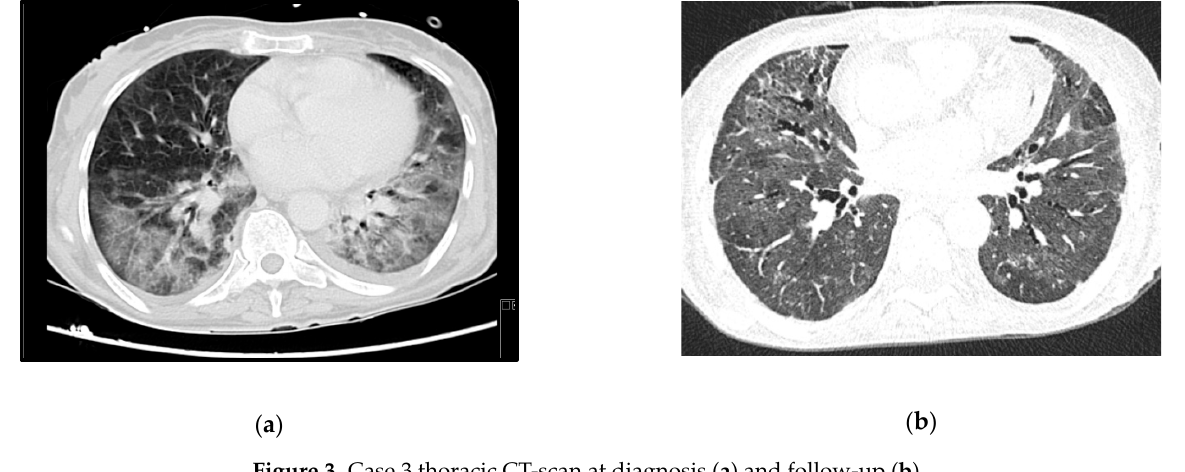
Figure 3. Case 3 thoracic CT-scan at diagnosis ( a ) and follow-up ( b